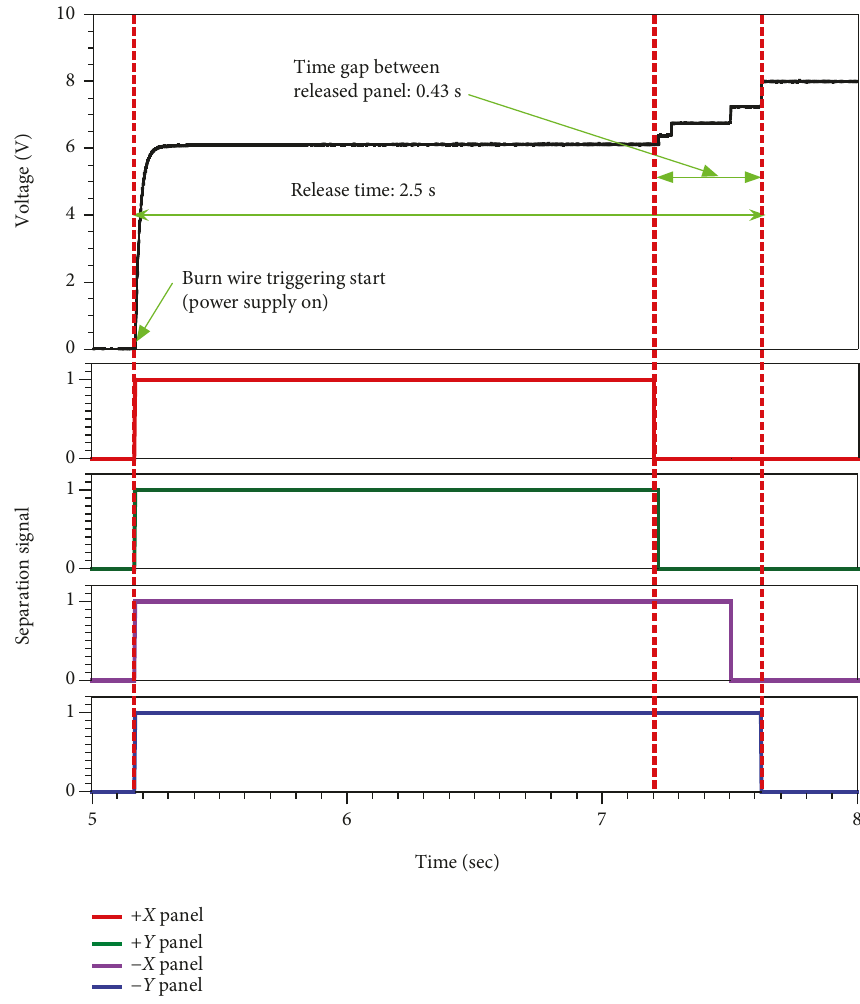
Figure 6: Time histories of input voltage and separation signals of each solar